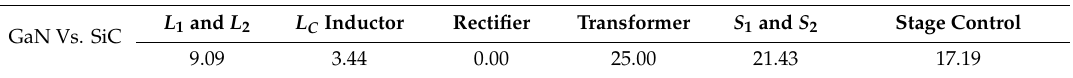
Table 10. Power reduction percentage; second vs. third